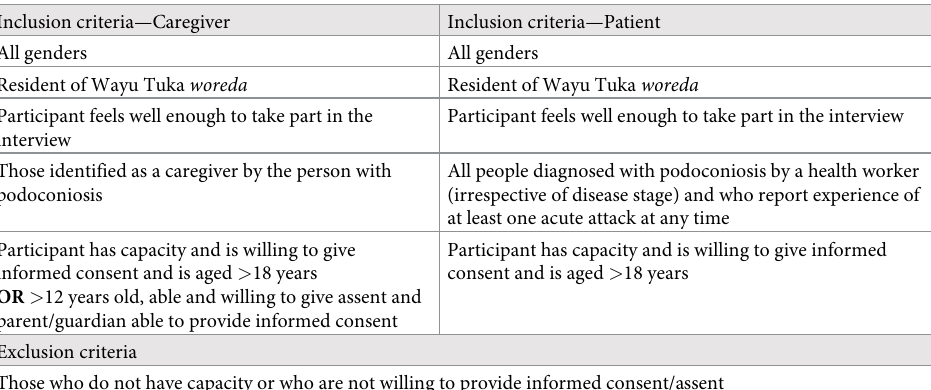
Table 1. Inclusion/exclusion